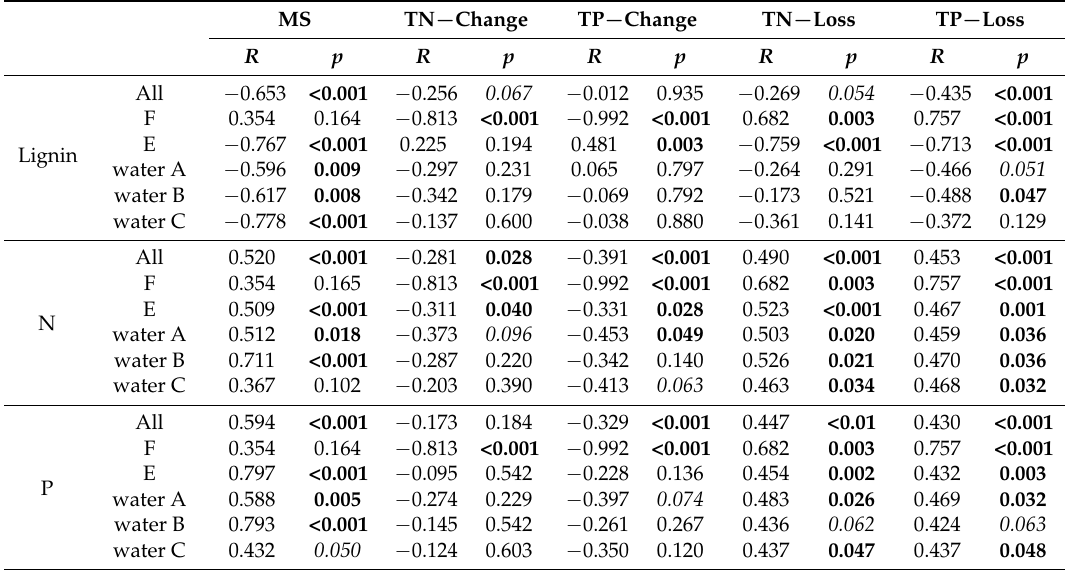
Table A1. Correlation Analysis between Initial Litter Quality (Lignin Concentration, TN and TP) and Litter Mass Loss, the Changes and Losses the TN, TP Losses. E represents emergent plants; F represents floating plants.